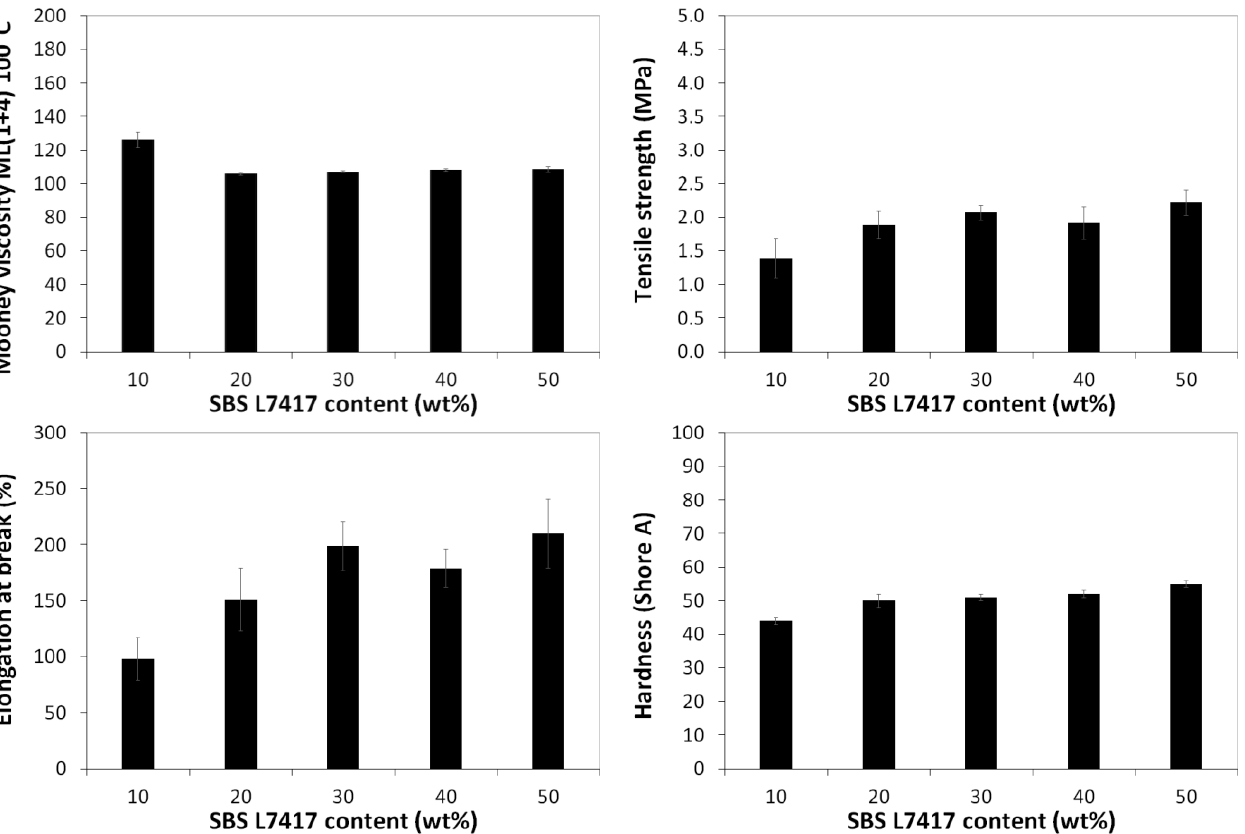
Figure 5. Mooney viscosity and mechanical properties of GTR modified by variable content of SBS L7417.